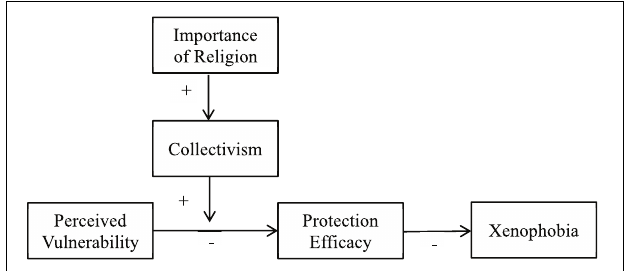
FIGURE 1 | Theoretical model of mediated moderation of importance of